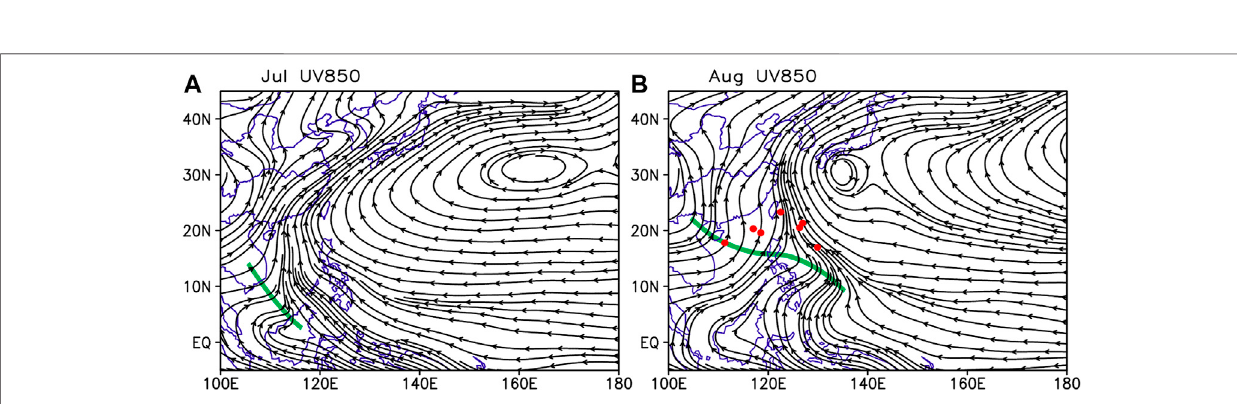
Frontiers in Earth Science |